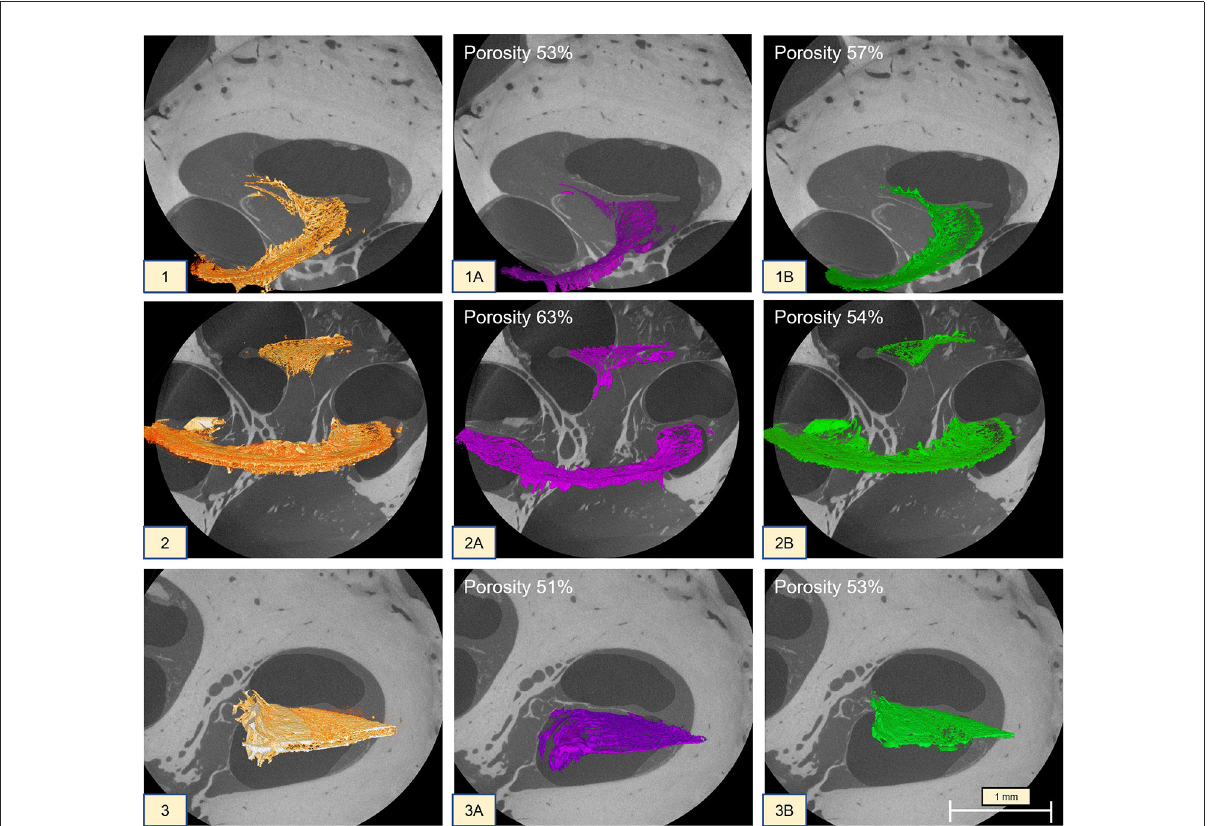
FIGURE8 MicroCT (1 at 2.35 µ m; 2 at 2.41 µ m; 3 at 2.48 µ m) of the cochlea turns. (1) Apex OSL; (1A) tympanic plate with 53% porosity; (1B) vestibular plate with 57% porosity; (2):midturn OSL (the CL was kept on the segmentation); (2A) tympanic plate with 63% porosity; (2B) vestibular plate with 54% porosity; (3) basal turn OSL; (3A) tympanic plate with 51% porosity; (3B) vestibular plate with 53% porosity.